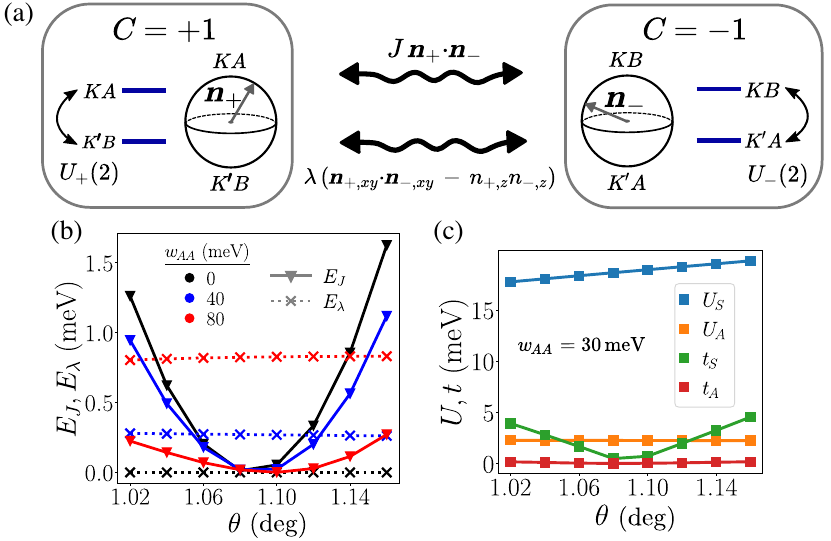
FIG. 2. Strong-coupling hierarchy and Chern pseudospins. (a) Schematic of Chern sectors with C ¼ (cid:2) 1 . In the isotropic limit, there is a U ð 2 Þ × U ð 2 Þ symmetry [U ð 4 Þ × U ð 4 Þ with spin]. At charge neutrality for a generalized ferromagnet with net C ¼ 0 , one can define pseudospins n . The dominant corrections can be captured as anisotropies J , λ (wiggly lines) which couple the Chern sectors and (cid:2) partially lift the symmetry. (b) NLSM parameters E J ¼ JA (triangles), E λ ¼ λ A (crosses) as a function of twist angle θ , and UC UC ≃ 1 . 5 meV calculated in the interlayer hopping parameter w AA , where A is the moir´e unit cell area. The pseudospin stiffness ρ UC PS isotropic limit does not depend on w AA and subtraction scheme (see Appendix A in Ref. [54]), and is largely insensitive to θ . (c) Strong- coupling energy scales U S , U A , t S , t A as a function of θ and w AA . All quantities are calculated using the average subtraction